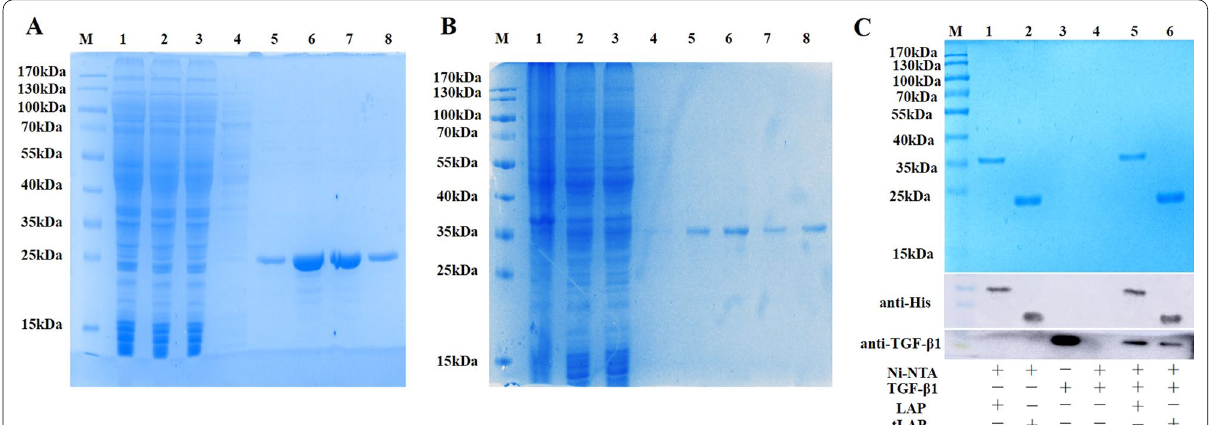
Fig. 2 Purification and identification of Recombinant LAP and tLAP. A Purification of recombinant tLAP. lane M, protein marker; lane 1, Crushing bacterium fluid; lane 2, Supernatant; lane 3, Precipitation after crushing; lane 4, wash; lane 5–8, elution for 4 times. B Purification of recombinant LAP. lane M, protein marker; lane 1, Crushing bacterium fluid; lane 2, Supernatant; lane 3, Precipitation after crushing; lane 4, wash; lane 5–8, elution for 4 times. C Identification of recombinant tLAP by pull down assay. M, protein marker; lane 1, LAP lane 3, TGF-β1; lane 4,